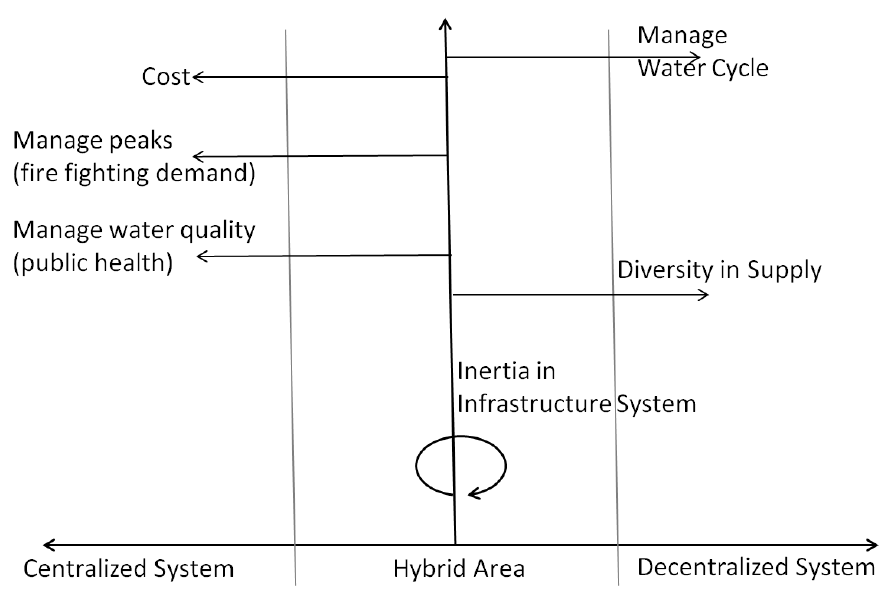
Figure 2. Inertia in water infrastructure